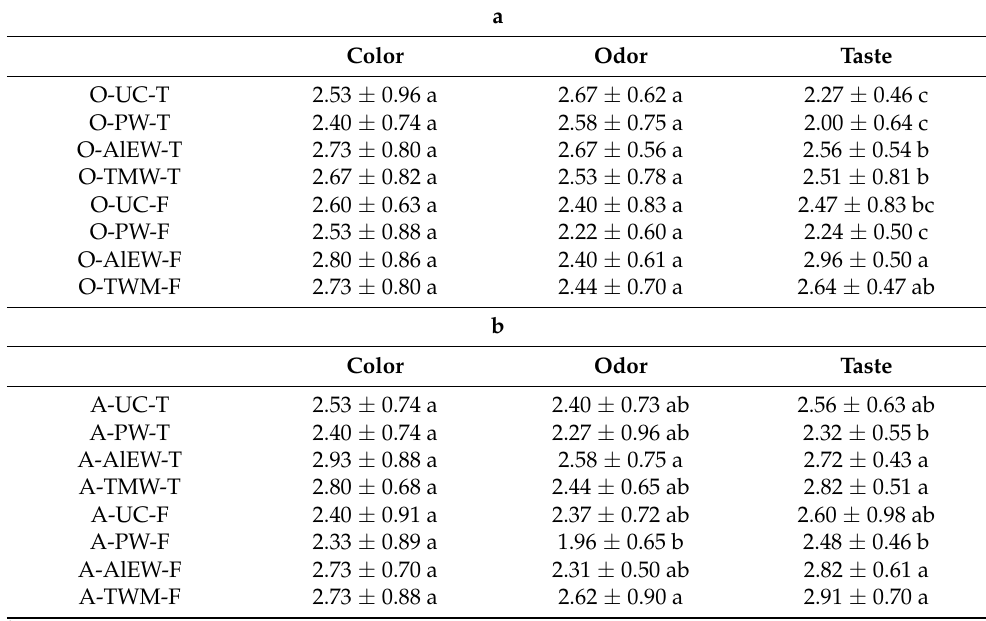
Table 3. The sensory evaluation of orange juice 1